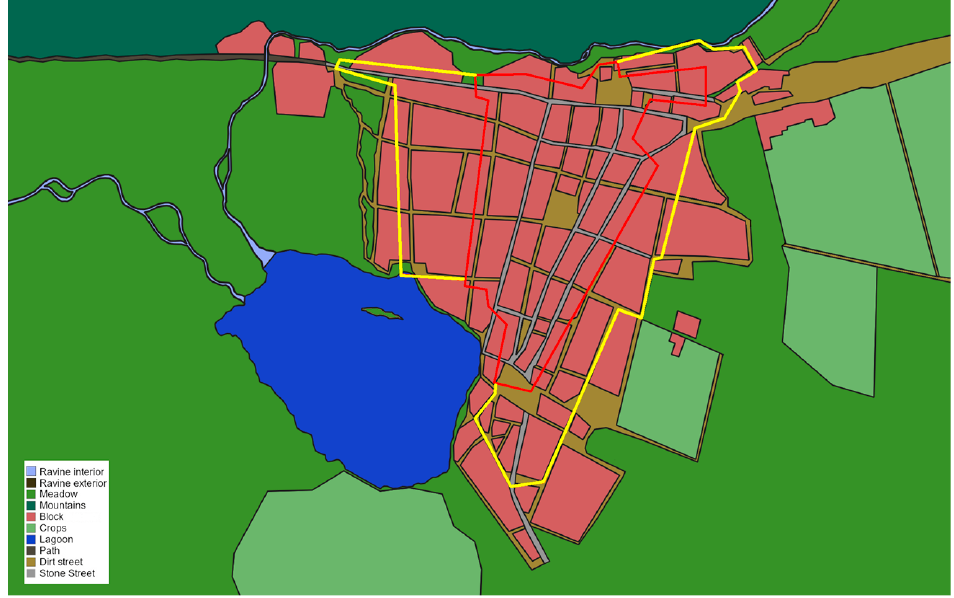
Figure 6. 2D layers related to the terrain over Torriani’s map.